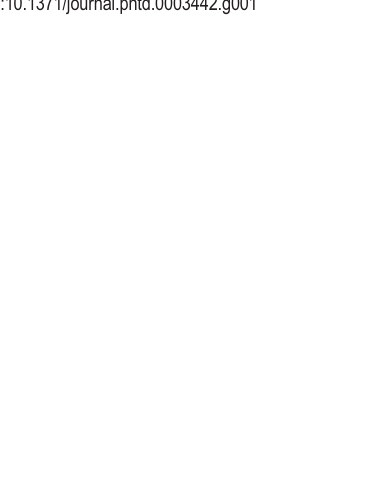
Figure 1. Origin and diversity of dengue viruses isolated from travelers entering Western Australia during 2010 – 2012. (A) Geographic origins of all imported DENV; (B) Geographic origin of individual DENV serotypes.